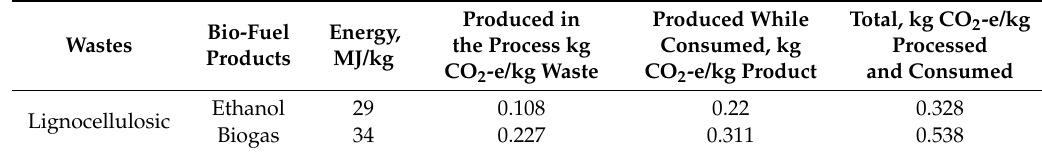
Table 4. CO 2 produced from production and usage of ethanol and